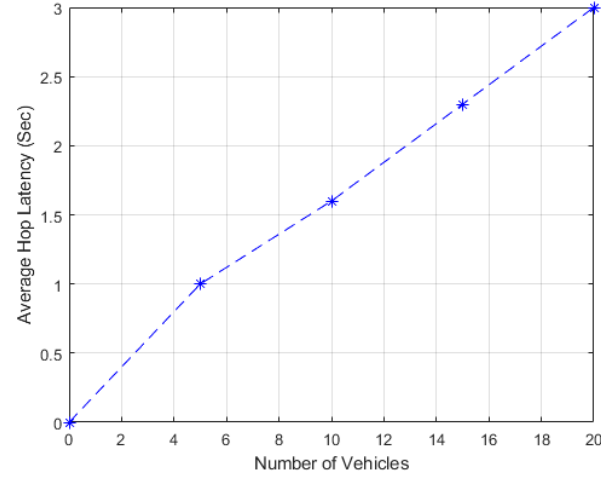
Figure 13. Average hop latency (router node load latency).